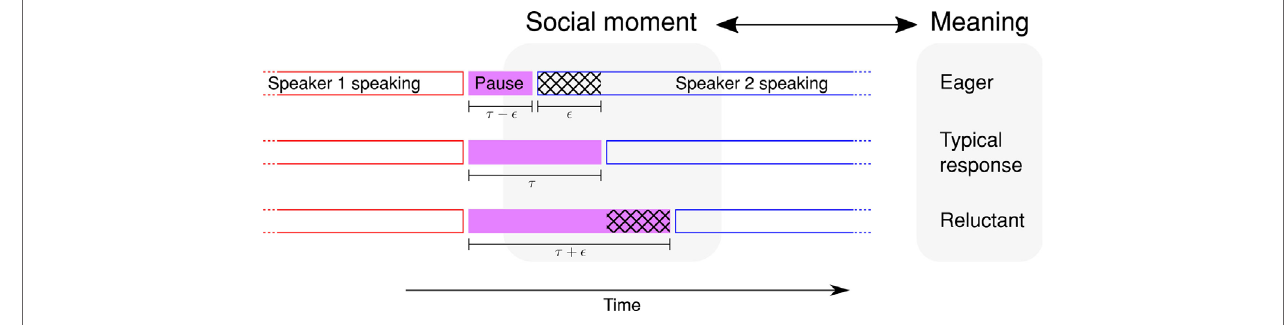
FigUre 1 | A social moment that occurs between two conversing people from the changing length of a pause. There is a pause between one speaker’s turn ending and the other speaker’s turn starting. The pause length is controlled by speaker 2, and different lengths of the pause can indicate different pragmatic meanings to speaker 1. Given a typical pause length, τ , a pause that is shortened and has length τ − 𝜖 might indicate eagerness to speak, while a pause that is lengthened has length τ + 𝜖 might indicate reluctance to speak. Such an event can be considered a social moment, as the event can have an impact on the interaction dynamics. The social moment is caused by the divergence from the typical behavior by speaker 2. Speaker 1 can interpret the event and change his/her approach to the conversation. Alternatively, speaker 1 could miss or misinterpret the social moment and appear anti-social to speaker